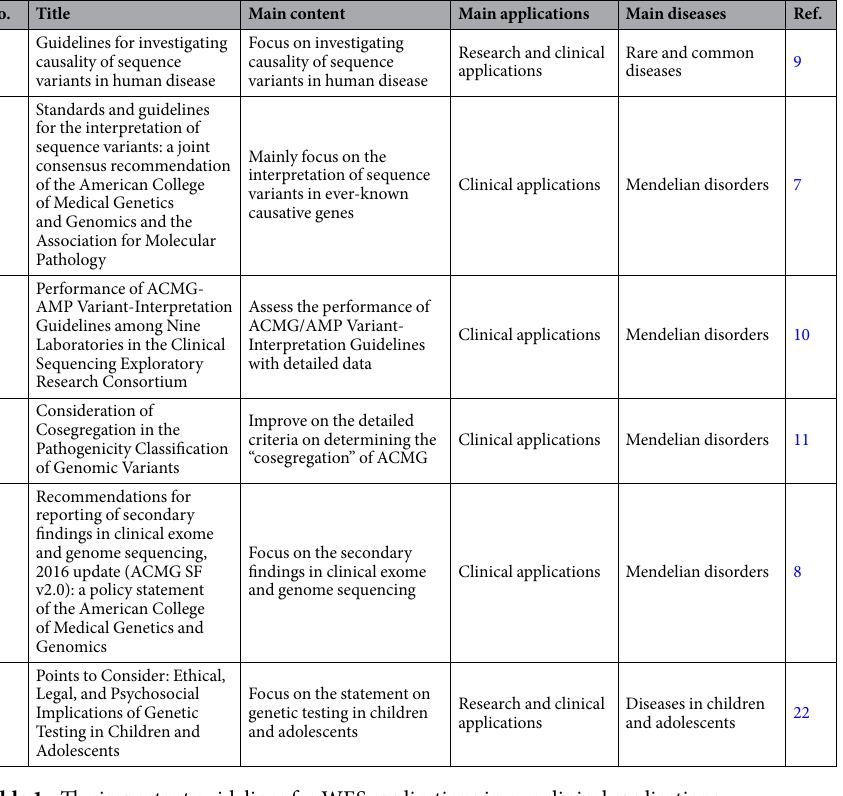
Table 1. The important guidelines for WES applications in our clinical